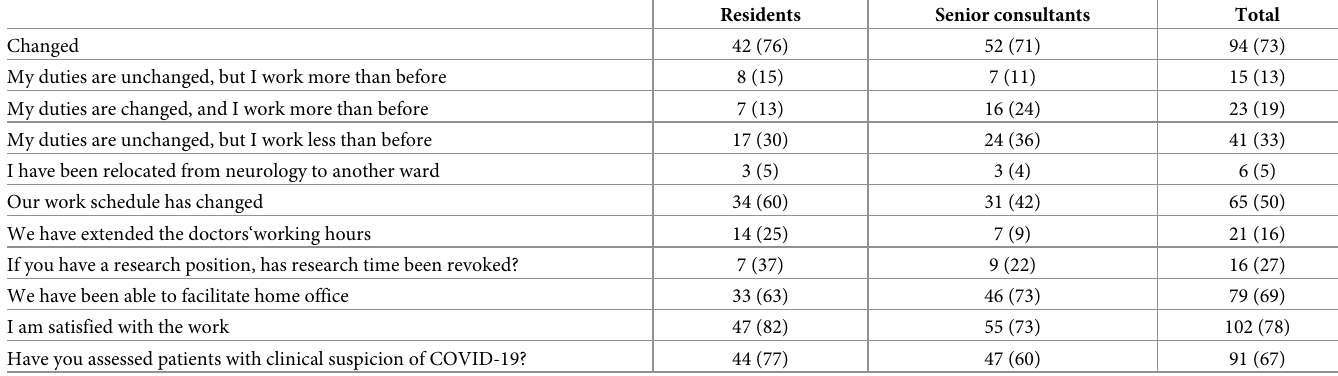
Table 2. What is your work situation like now as compared to normal? n